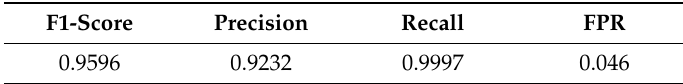
Figure 7. Performance of the best anomaly detection method configuration for each window size in the flow collector. The selected configuration for each method is the one that obtained the highest F1-score among all the configurations that properly detected at least 50% of each ransomware. Table 5. F1-Score, precision, recall and false positive ratio (FPR) values of OC-SVM for a sliding flow window size of 10